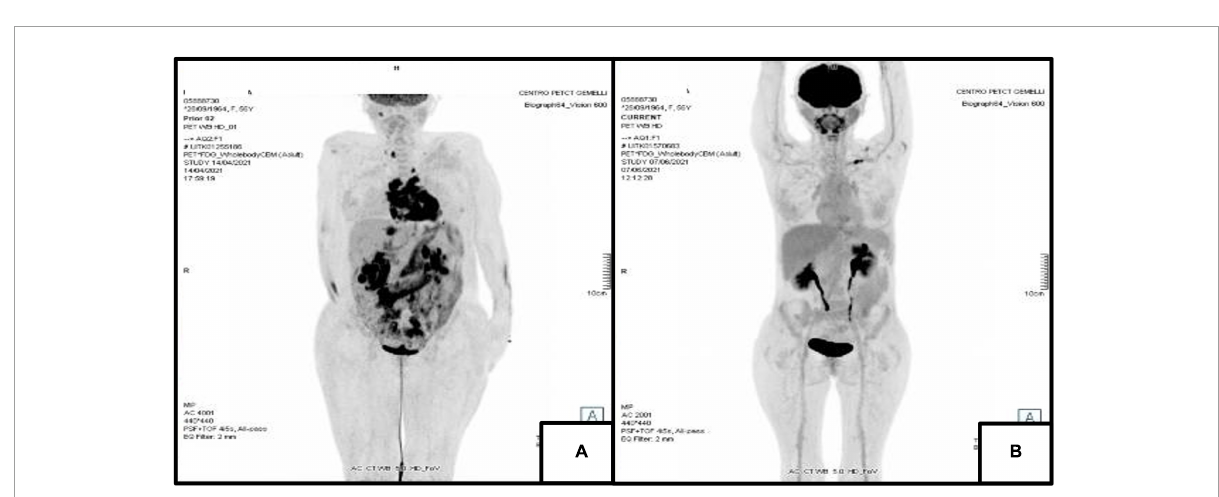
FIGURE2 18F-FDG Positron Emission Tomography. (A) PET/CT of April 2021 showing disease with intense metabolic activity in the following areas: SVC, aortic root, pulmonary artery, both atria, IAS, IVS and LV in the thorax and liver, both kidneys, mesenterial adipose tissue, annexes and several lymph nodes in the abdomen. (B) PET/CT of June 2021 showing an almost complete resolution of pathological metabolic activity both in the thoracic and abdominal previous sites of